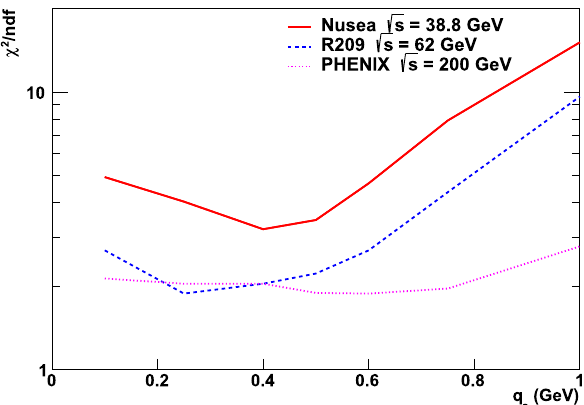
Fig. 8 The χ 2 / ndf asafunctionofthewidthoftheintrinsictransverse momentum distribution, obtained from a comparison of the measure- ments (NuSea [42,43], R209 [41], PHENIX [40]) with a prediction at NLO using PB-TMDs. For the theory prediction only the central value is taken, but no uncertainty from scale variation is